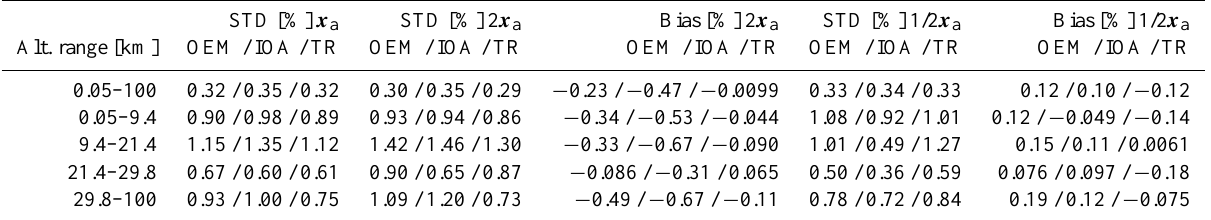
Table 7. Impact of different choices of x a on the O 3 total and partial columns retrieved with the OEM, IOA and TR, for the 2007 campaign data at Ile de La R´eunion: mean daily relative STD and mean relative biases with respect to the retrieval with x a .